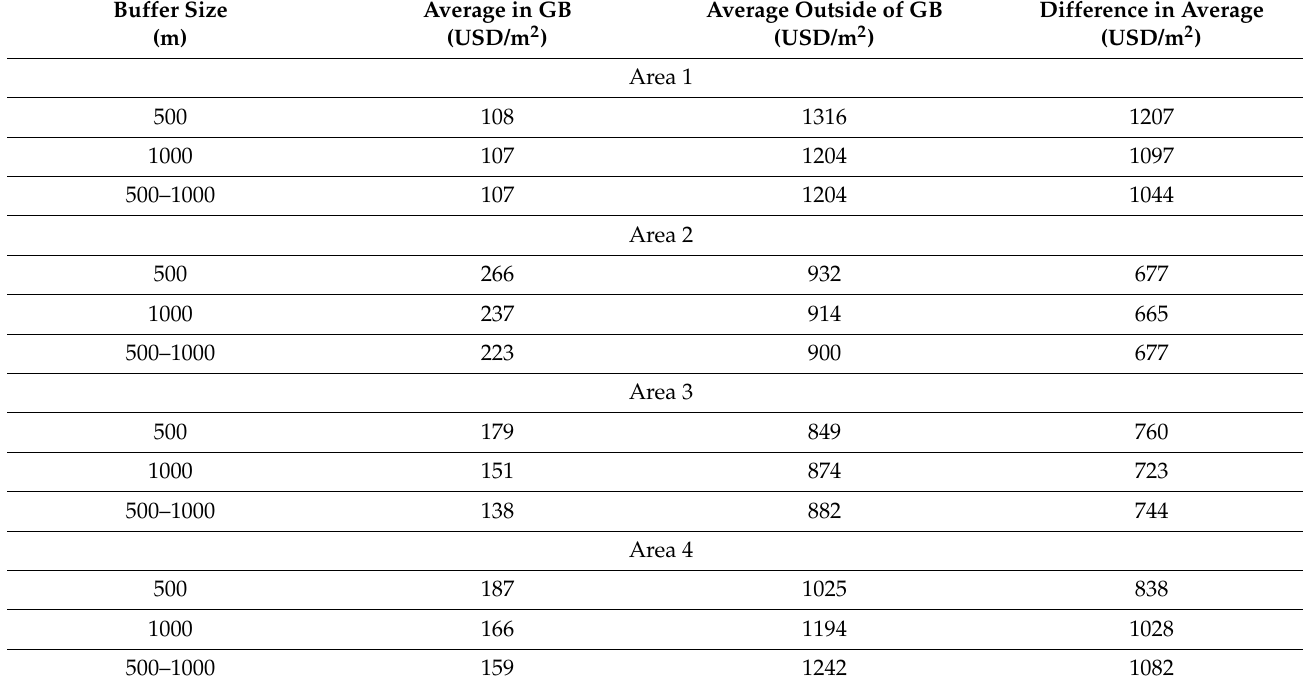
Table 4. Land price in the targeted areas.